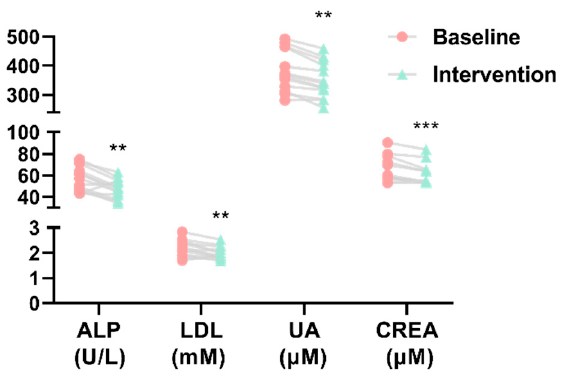
Figure 4. Serum concentration of blood biochemical indices (** p -value < 0.01, *** p -value < 0.001 compared with baseline group). ALP (alkaline phosphatase), LDL (low-density lipoprotein), UA (uric acid), and CREA (creatinine). Table 1. Routine hematological examinations of whole blood for baseline and intervention period. Blood Routine